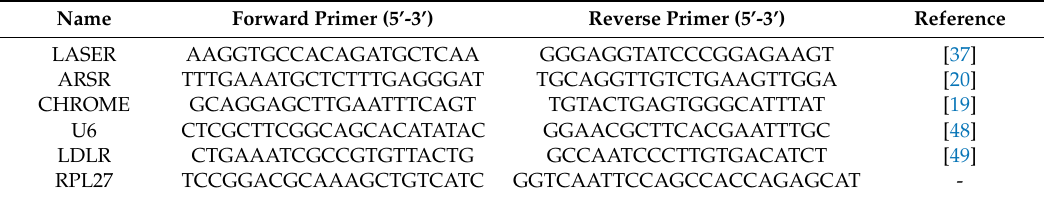
Table 3. Sequences of primers used to quantify gene expression by